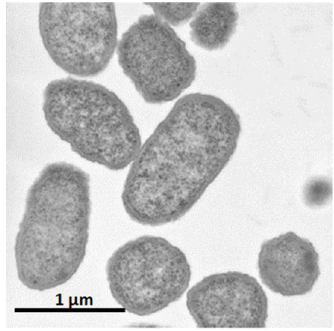
Figure 2. Electron micrograph of Pantoea ananatis AJ13355 at a magnification of ×30,200.